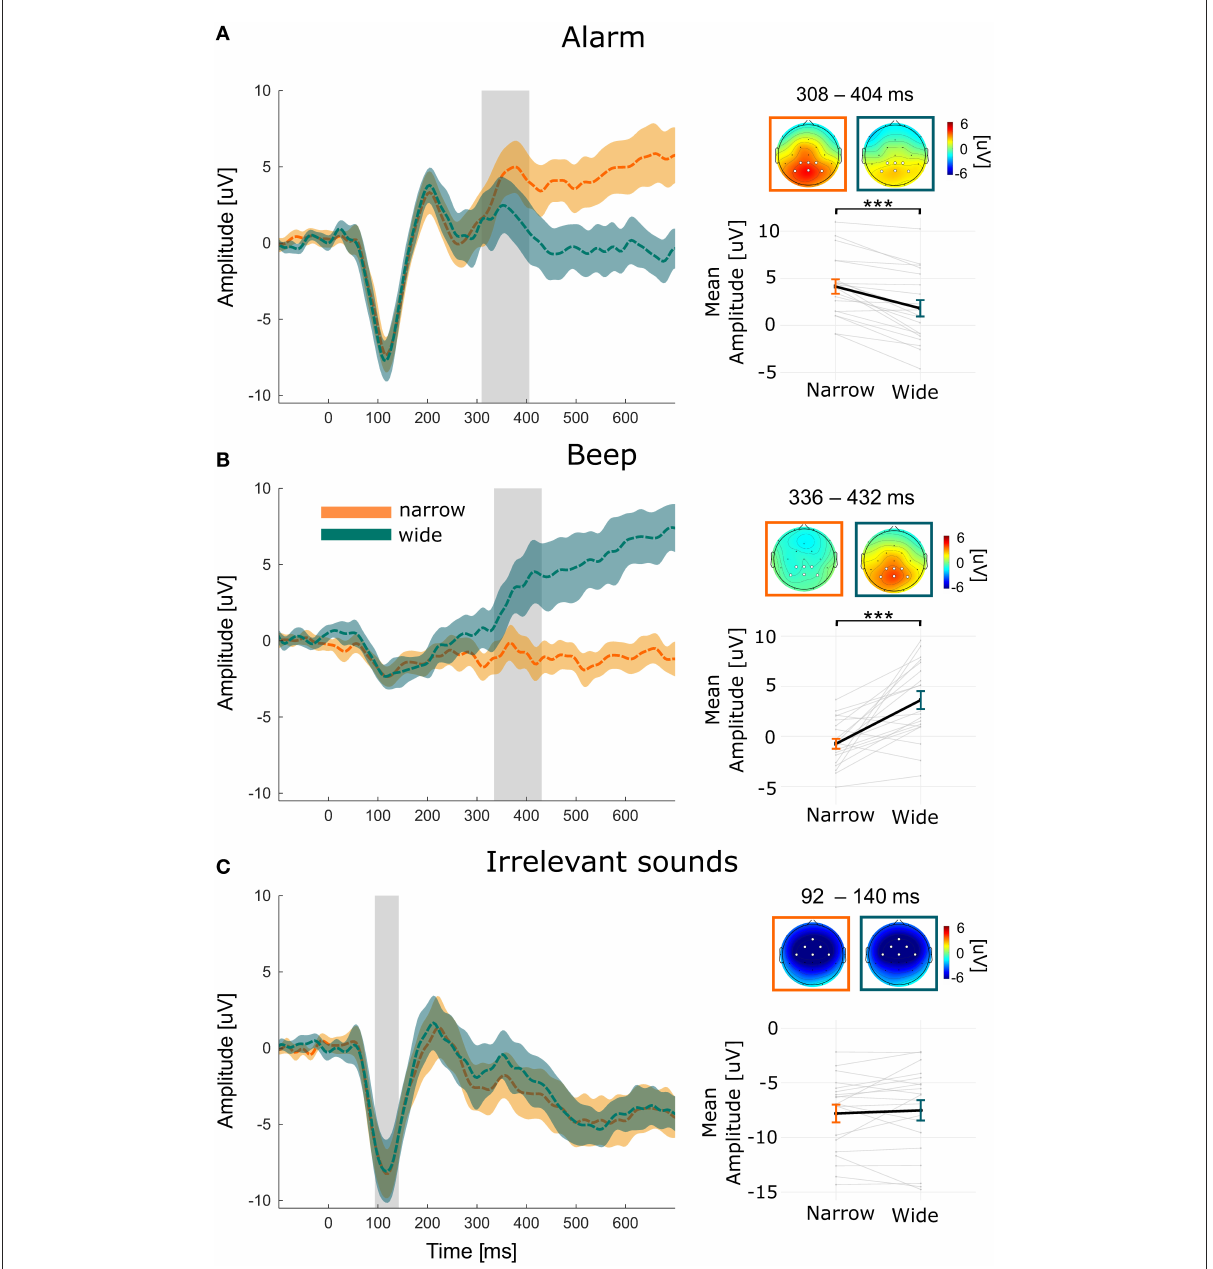
FIGURE3 ERPs of the (A) Alarm, (B) Beep, and (C) Irrelevant sounds for each condition and averaged over participants and selected channel. The selected channels are marked in white in the topographies. The narrow and wide condition are marked with orange and green, respectively. Color shades indicate the 95% confidence interval. The gray area indicates the average time-window and the topographies show the average amplitudes averaged over this time-window. Note, that individual time-windows were used for the statistical comparison. Below the topographies, the fixed effects (thick black lines) and the variability of effect between individuals (i.e., each gray line corresponds to one participant) are displayed. *** p <